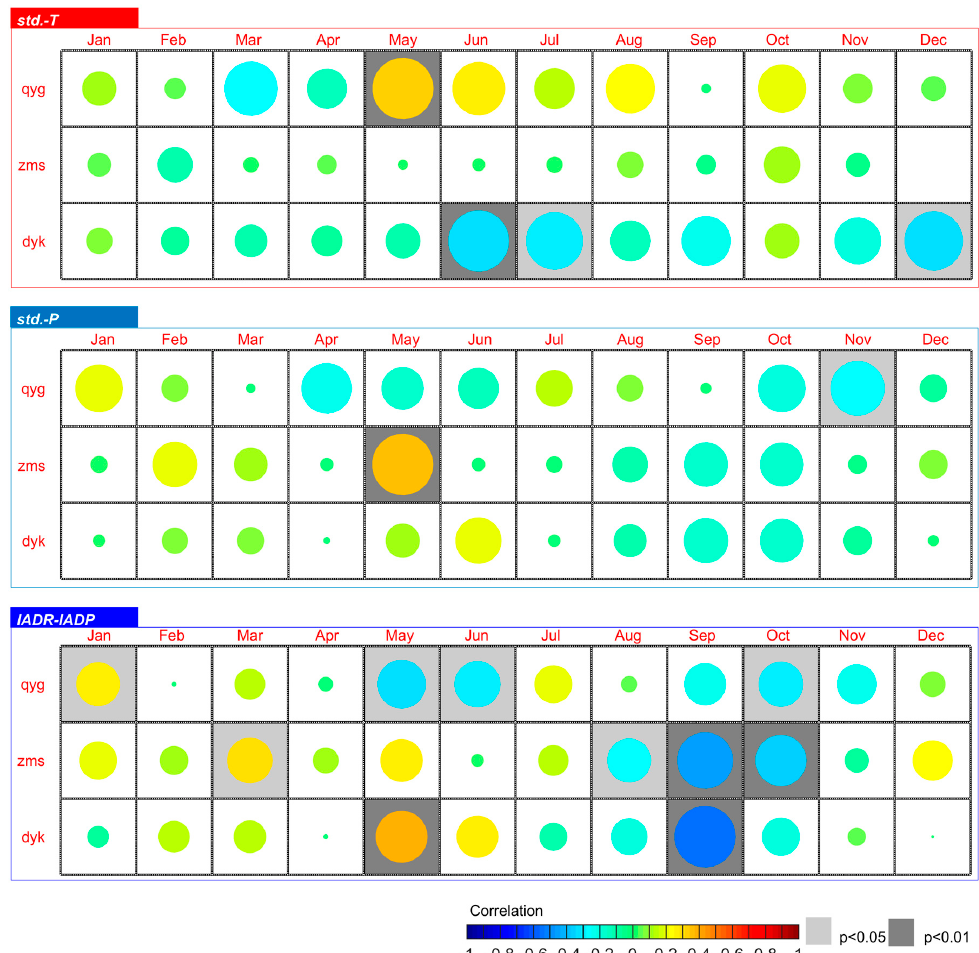
Figure 3. Climate-growth response of Qinghai spruce at all sampling sites; the upper panel shows correlations between standard wring width indices (std.) and temperature (T), the middle panel shows the correlations between standard wring width indices (std.) and precipitation (P), and the lower panel shows correlations between the inter-annual difference of standard wring width indices (IADR) and the inter-annual difference of precipitation (IADP); the larger the circle is, the stronger the correlation.